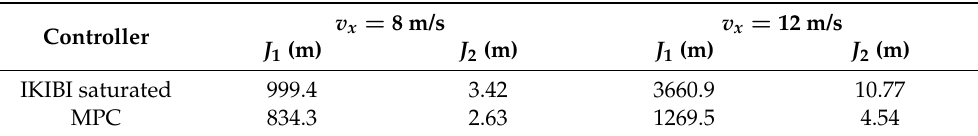
Figure 6. Vehicle path: fast sensor feedback test with noise using EKF. ( left ) v x = 8 m/s and ( right ) v x = 12 m/s. Table 2. Cost indexes: fast sensor feedback test with noise using